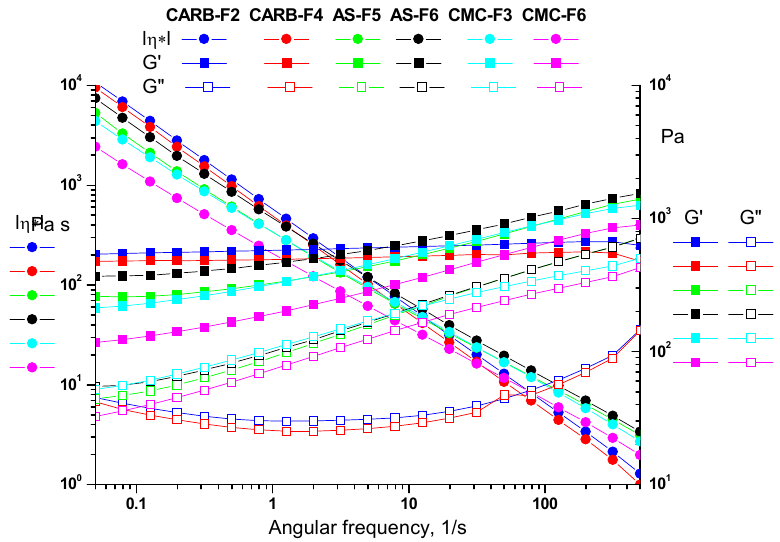
Figure 2. Amplitude sweep for simple gels (CARB-F2, AS-F5, and CMC-F3) and gels with CD-NHF (CARB-F4, AS-F6, and CMC-F6). G’: storage modulus; G”: loss modulus.